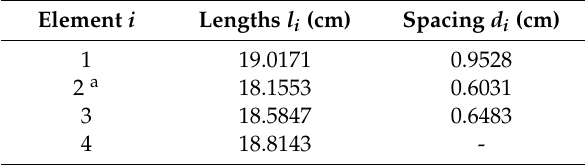
Table 4. Description of the prototyped antenna at 8.5 GHz. Parameters according to Figure